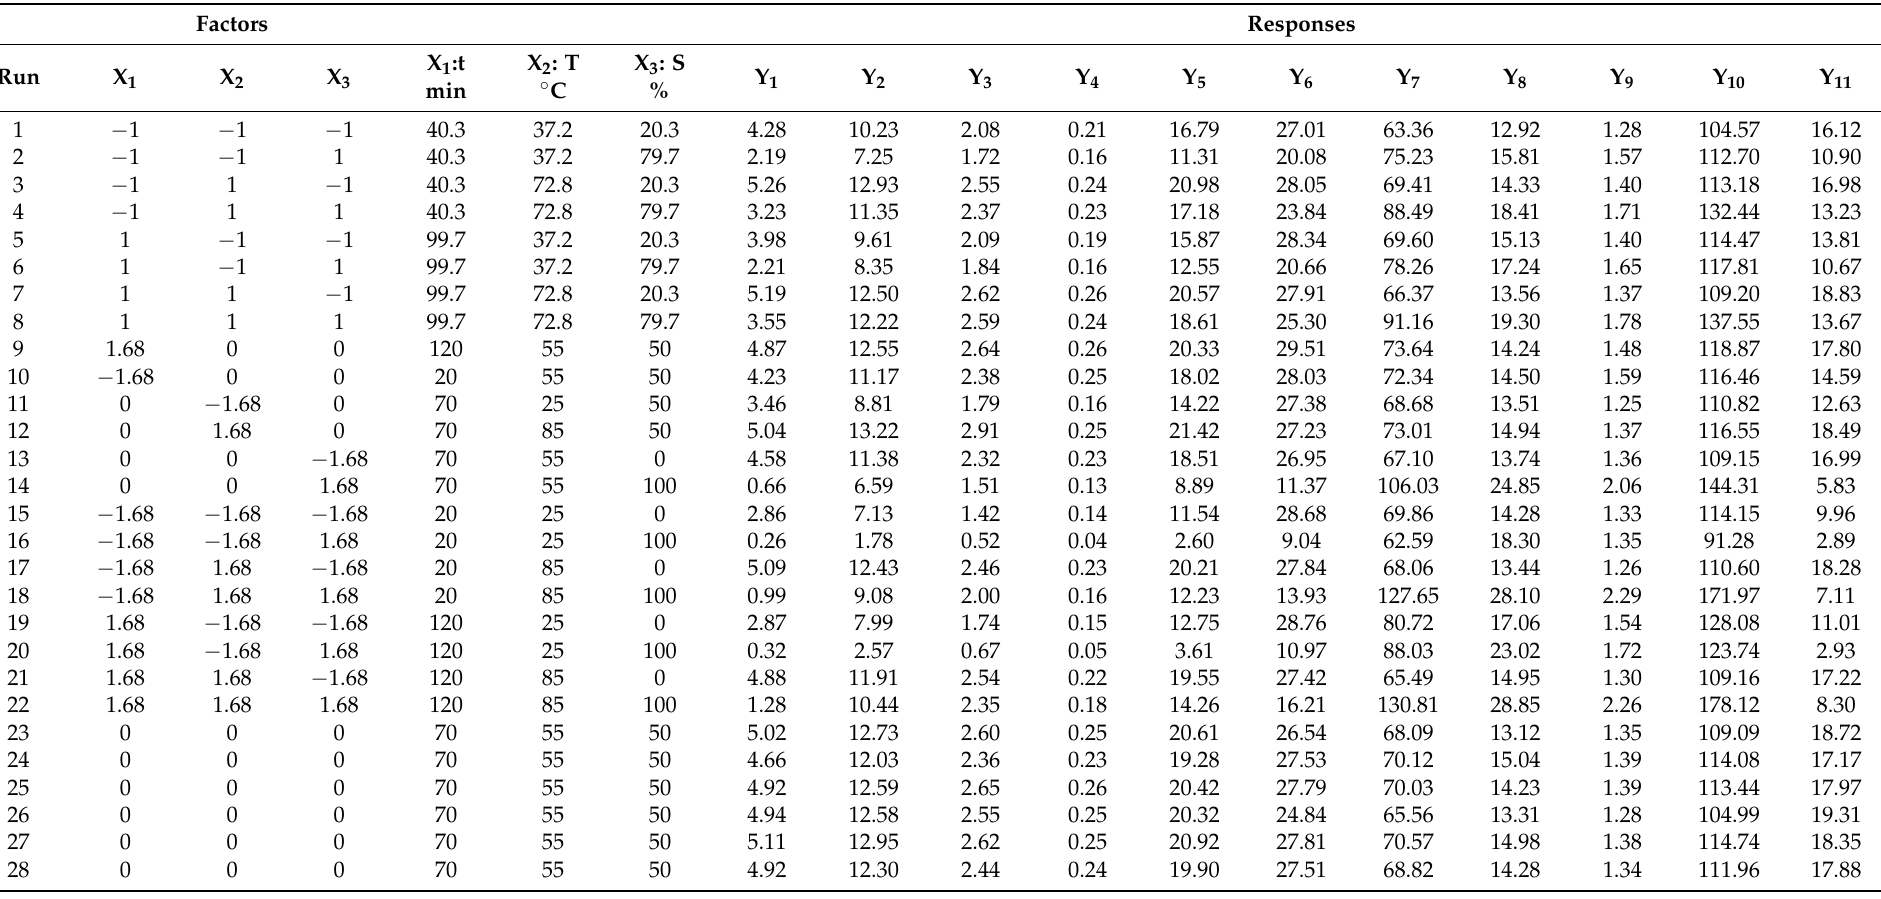
Table 1. Circumscribed central composite design and experimental data for 5-level-3-factor response